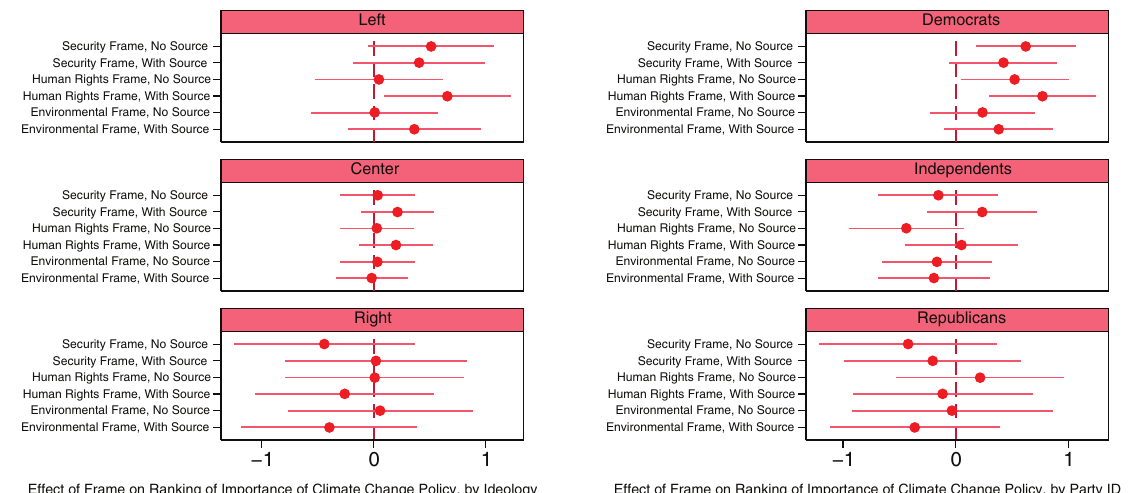
Fig 4. Climate change framesand rankings of the importance of climate change policy, over ideology and partisanship. Note: Horizontalbars indicate90% confidenceintervals. “Left” is those who reporteda 0–10 ideologyof 0, “Center” is 5, and “Right” is